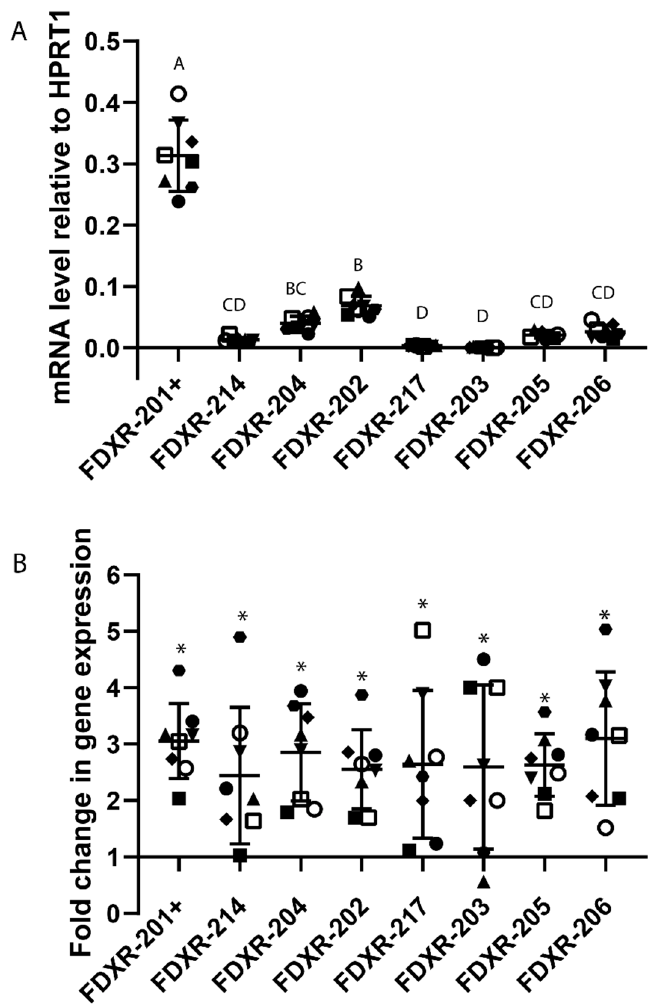
Figure 5. Gene expression profile of FDXR variants in blood from Endometrial cancer patients treated with radiotherapy. The variants basal level of expression was compared between the patients ( n = 8) ( A ). FDXR variants fold of change in expression 24 h after the first fraction (1.8 Gy) are represented in panel B. The fold change is represented in the graph and values over 1 or below 1 indicate an increase or decrease with respect to control values ( B ). Individual data points are shown for all patients, together with the mean ± SD (each patient is represented with a di ff erent symbol). One-way ANOVA followed by Tukey’s test was performed for statistical analysis. Values not sharing a common letter are significantly di ff erent. No significant di ff erences were found between variants in panel B. Significant di ff erences (paired t -test, p ≤ 0.05) with the control were indicated with an asterisk (*) in panel